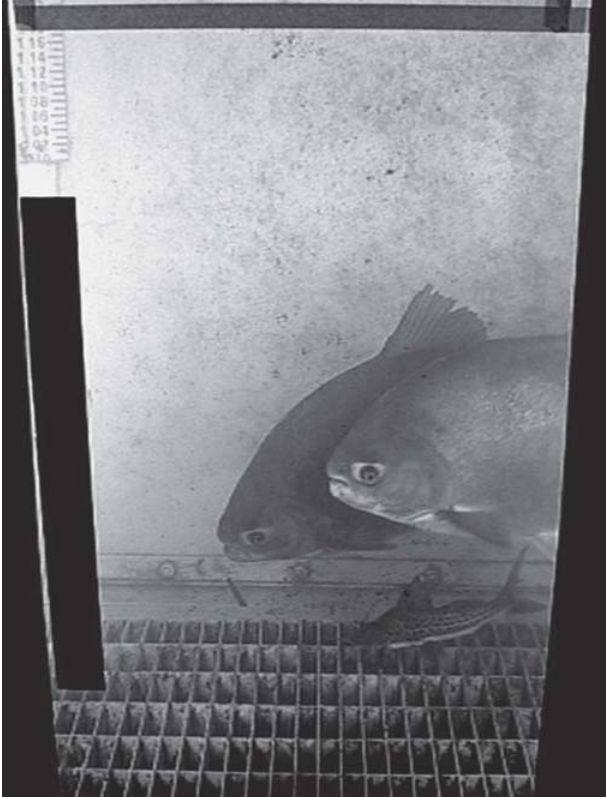
Fig. 2. Still image capture of two Piaractus mesopotamicus and one Pimelodus maculatus, upstream direction, registered by the video counter.